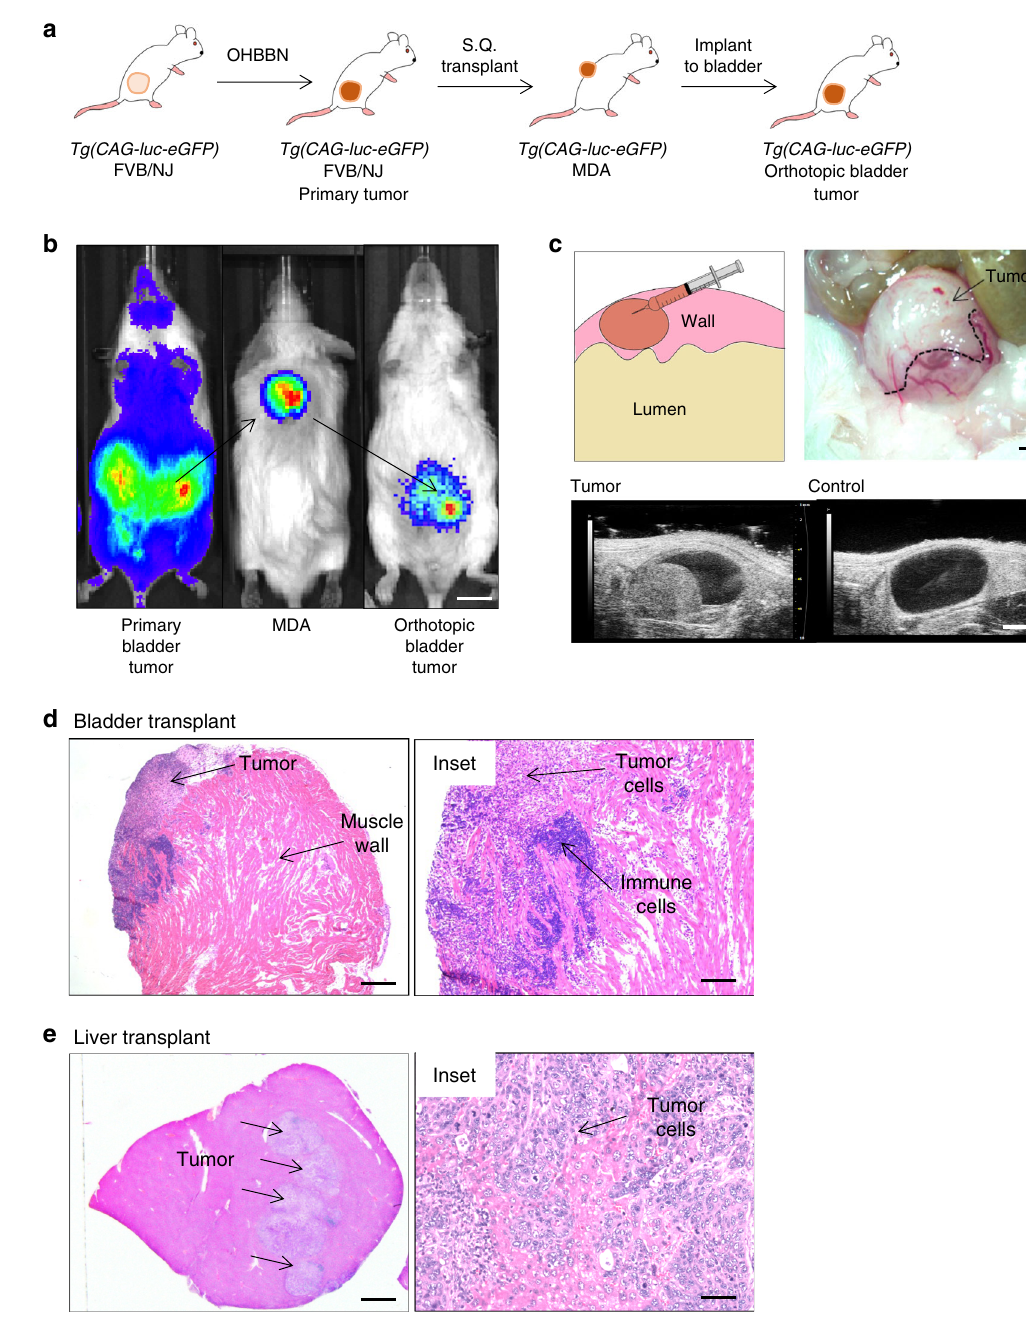
Fig. 5 Modeling lineage plasticity using in-vivo transplantation of mouse bladder cancer subpopulations. a Schematic showing the propagation of carcinogen induced, transplantable bladder cancers in FVB/NJ mice. FVB/NJ Tg(CAG-luc-eGFP) mice were treated with OHBBN followed by surgical resection of primary tumors and their subcutaneous (S.Q.) transplantation to FVB/NJ mice. Established primary tumors and mouse derived allografts (MDAs) were successfully passaged, used for surgical implantations to the bladder wall or liver. b Bioluminescence imaging of a primary tumor-bearing mouse (left), derived S.Q. tumors (middle), and mouse with implanted tumor cells to the bladder muscle wall (right) (Bar = 7 mm). c Schematic, gross image, and ultrasound images of tumor cell implants to the bladder muscle wall (top bar = 4 mm, bottom bar = 3 mm). d Histology of tumors transplanted to the bladder showing immune cells and invasive pathology (left bar = 500 μ M, right bar = 150 μ M). e Histology of tumor cells transplanted to the liver showing lesion formation and high-grade pathology (left bar = 2 mm, right bar = 50 μ M). These studies were reproduced with at least 50 biological